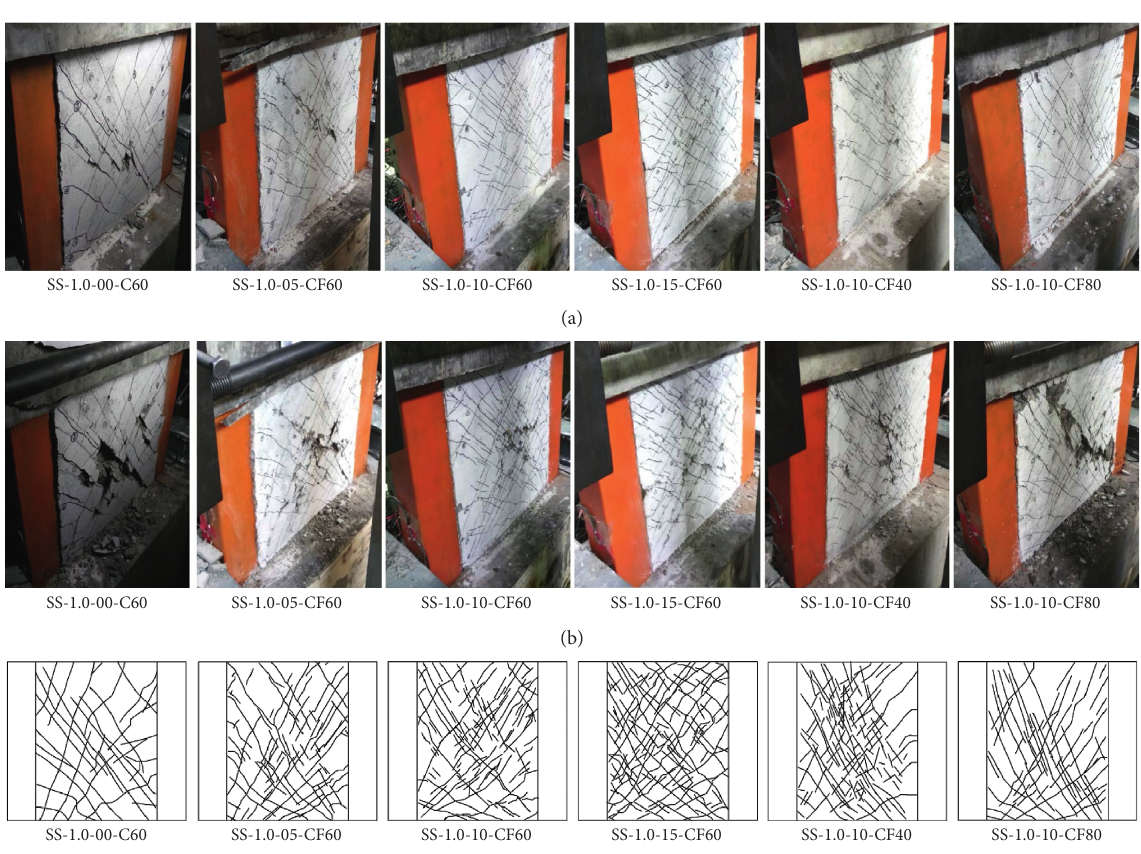
Figure 5: Failure pattern and crack distribution of shear wall specimens. (a) Failure pattern at peak state. (b) Failure pattern at ultimate state. (c) Schematic view of crack distribution.